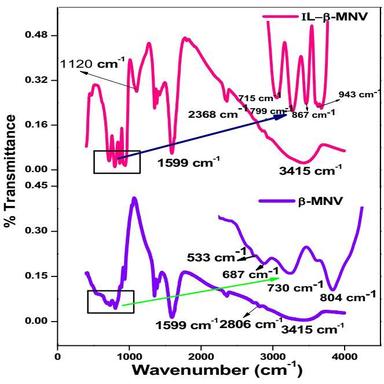
FT-IR spectra of β-MNV and IL-β-MNV.